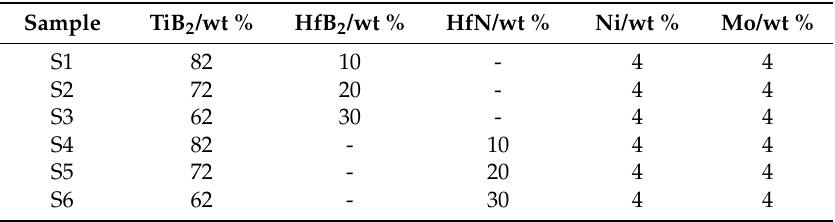
Table 1. Compositions of TiB 2 -HfB 2 and TiB 2 -HfN ceramic tool